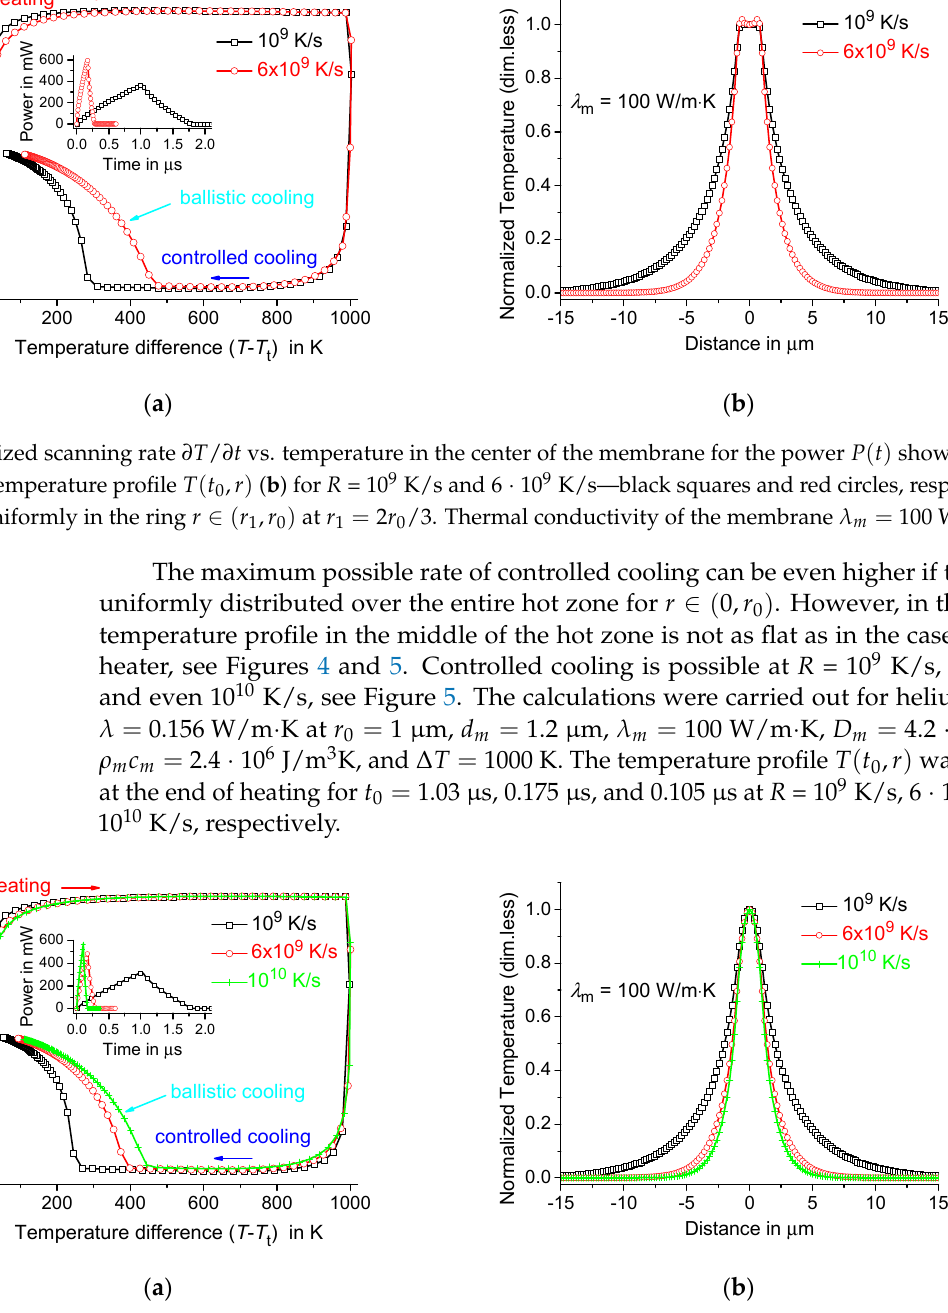
Figure 5. Normalized scanning rate ∂ T / ∂ t vs. temperature in the center of the membrane for the power P ( t ) shown in the inset ( a ) and the temperature profile T ( t 0 , r ) ( b ) for R = 10 9 K/s, 6 · 10 9 K/s, and 10 10 K/s—black squares, red circles, and green crosses, respectively. The heater acts uniformly in the disk r ∈ ( 0, r 0 ) . Thermal conductivity of the membrane λ m = 100 W/m · K.